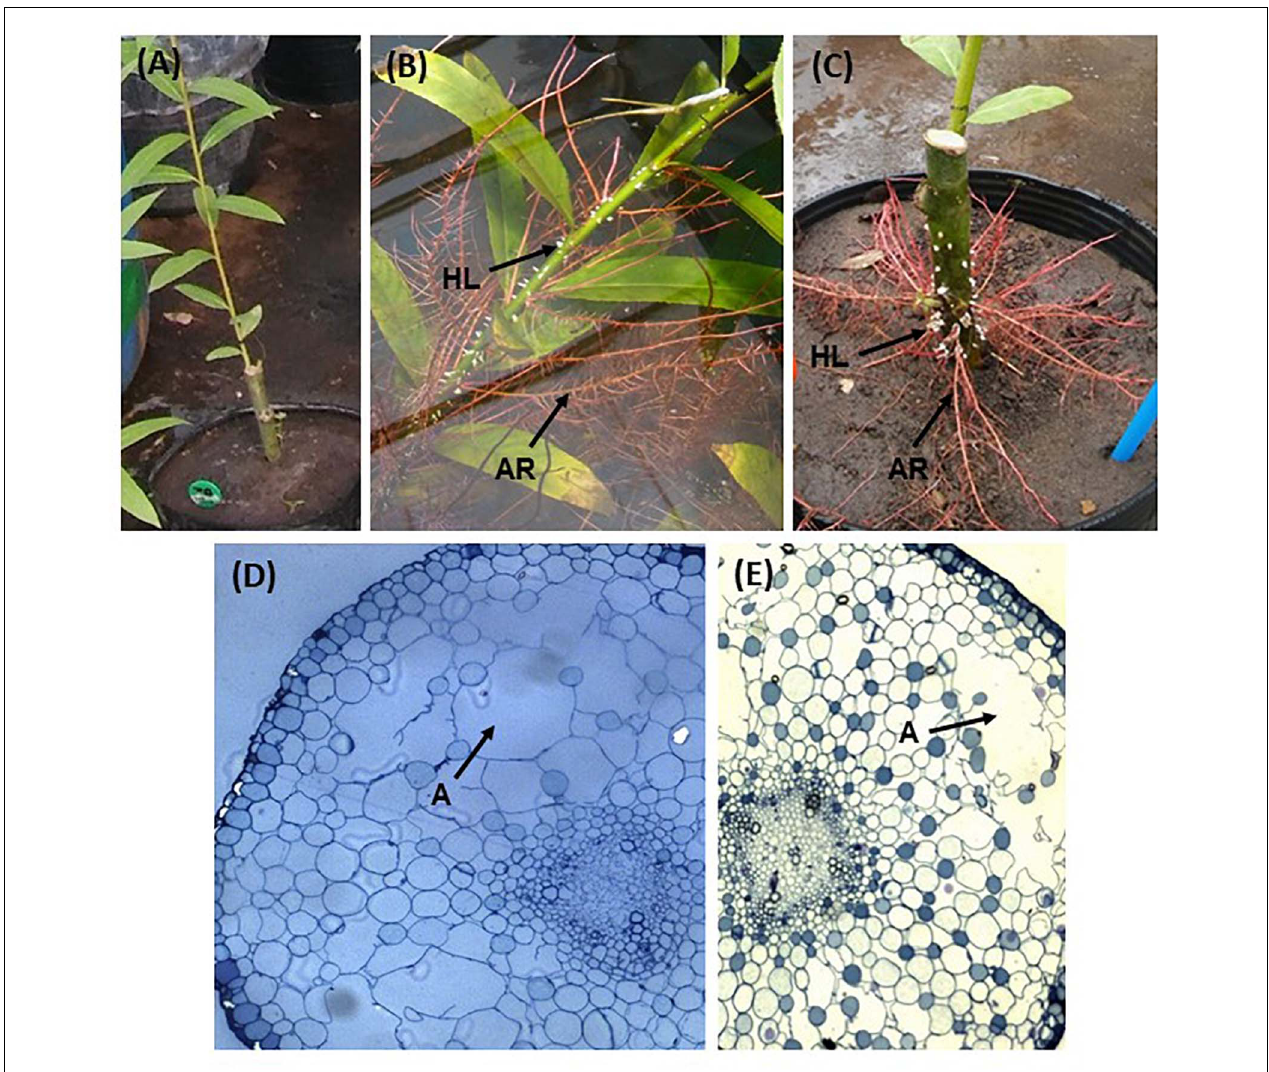
FIGURE 1 | View of the stem of a control plant, without development of hypertrophied lenticels or adventitious roots (A) ; hypertrophied lenticels (HL) and aquatic roots (AR) in plants of F40 treatment (B) ; aquatic roots and lenticels outside water in a plant from F10 treatment (C) ; a transversal view of F40 aquatic roots ( D , 10 × ); and a transversal view of an aquatic root in F10 ( E , 10 × ). (A) aerenchyma